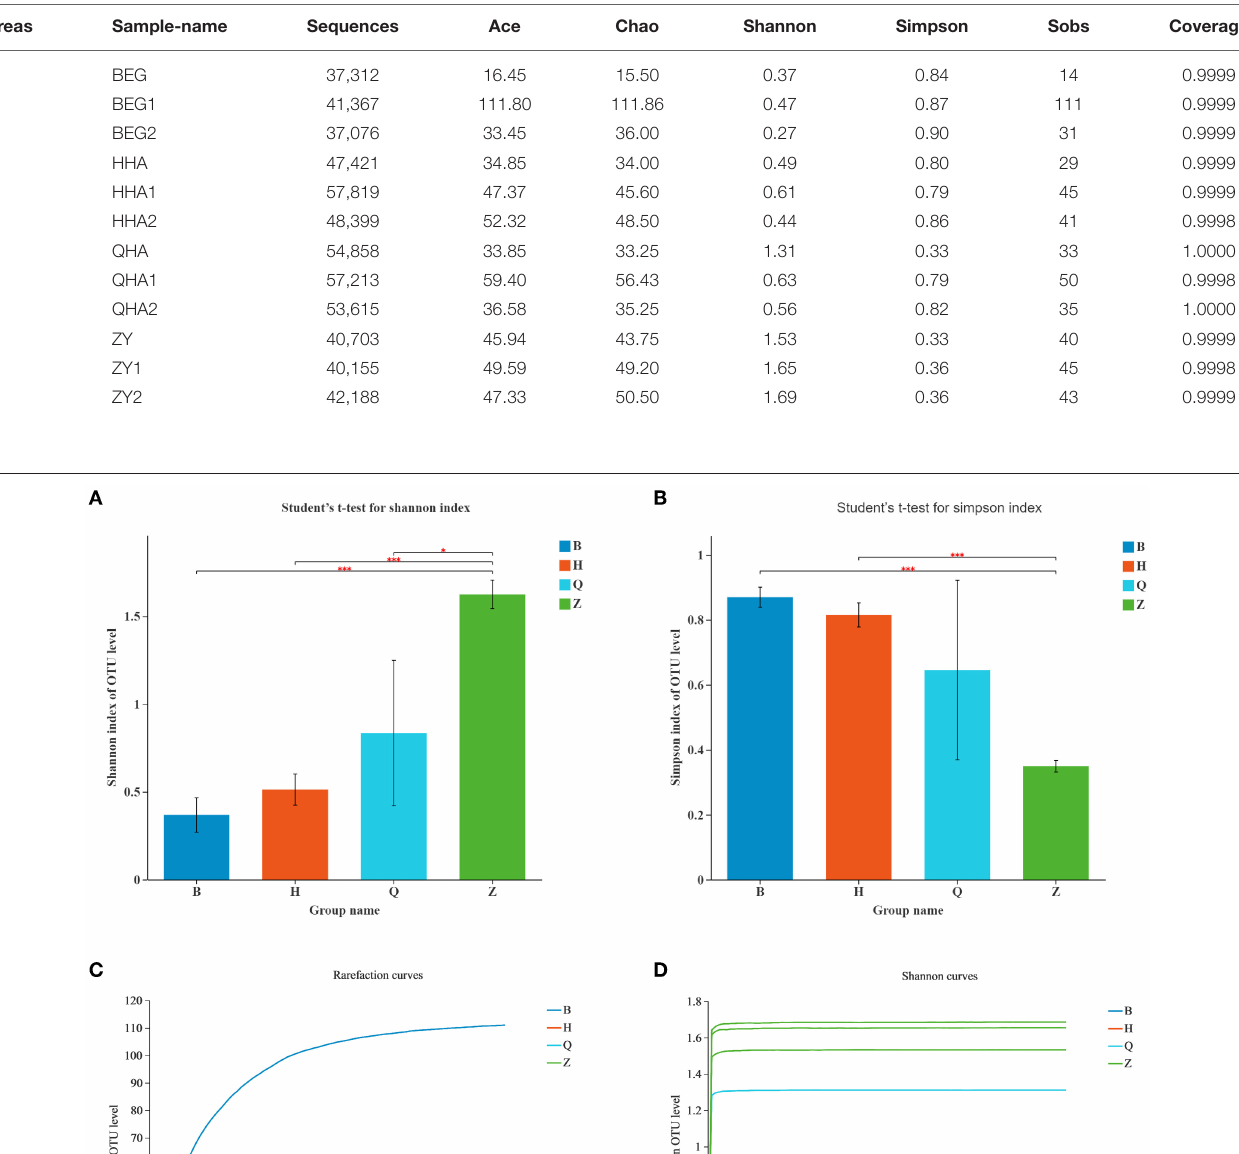
Frontiers in Nutrition |